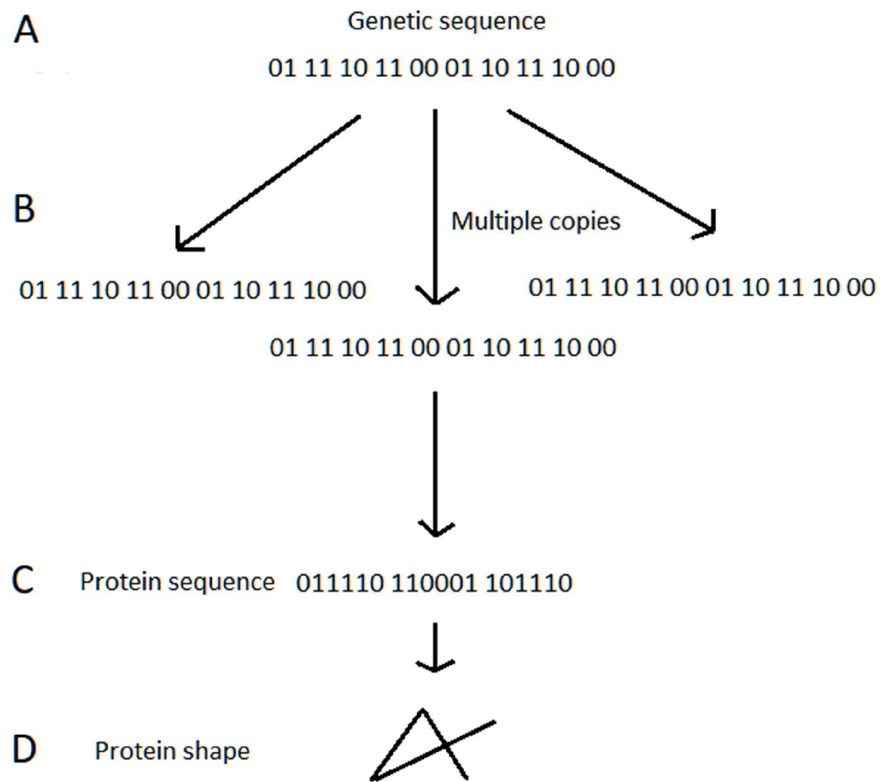
Figure 4. Simplification of the pathway for conversion of a one-dimensional genetic sequence to a three-dimensional protein shape. ( A ). Genetic sequence where each word is 2 bits in width. This sequence is representative of the proximate code of a protein molecule; ( B ) multiple copies of the genetic sequence are created from ( A ); ( C ) protein sequence is formed from ( B ), encoded by each word of the genetic sequence of a width of 6 bits, although the bit size is compressible in the corresponding protein code; ( D ) protein shape in three dimensions, where the shape is formed by the dynamics of physical interactions within the protein and between other molecules.